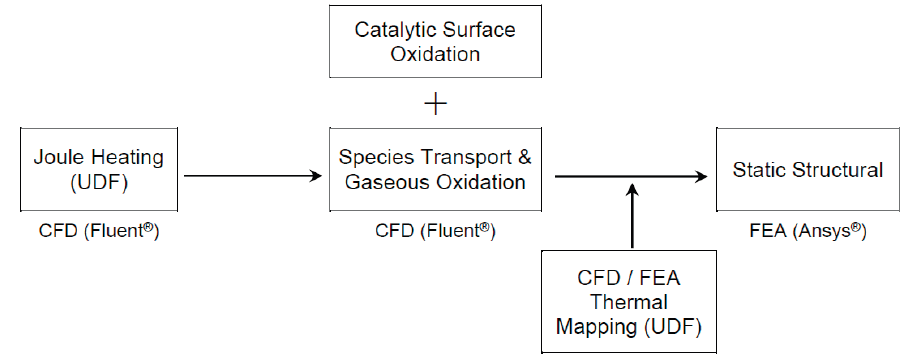
Figure 2. Schematic of a complete model of an electro-thermally actuated